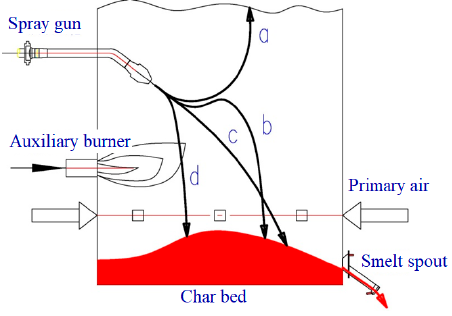
Figure 4. Diagrammatic sketch of combustion chamber.